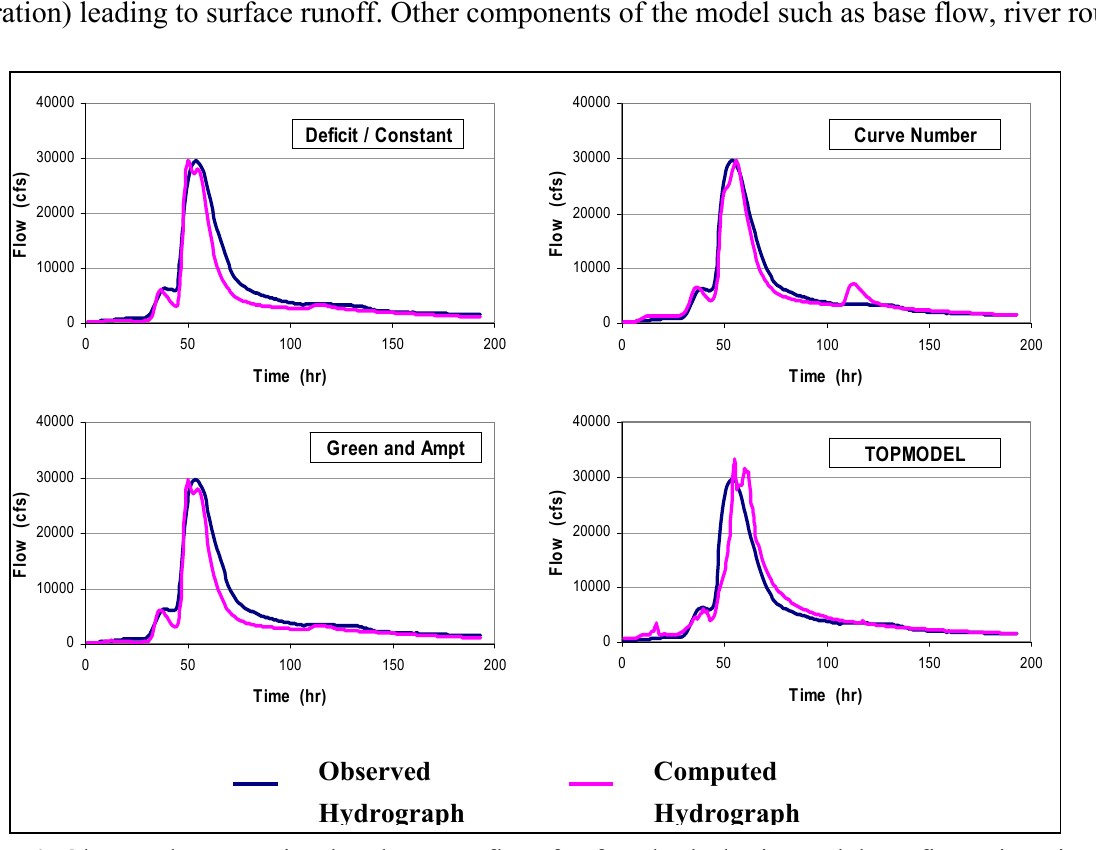
Figure 4. Observed versus simulated stream flow for four hydrologic model configurations in the UC river basin ( taken from Harris, 2007). Note: Other than TOPMODEL, all other configurations shown above can be set up in